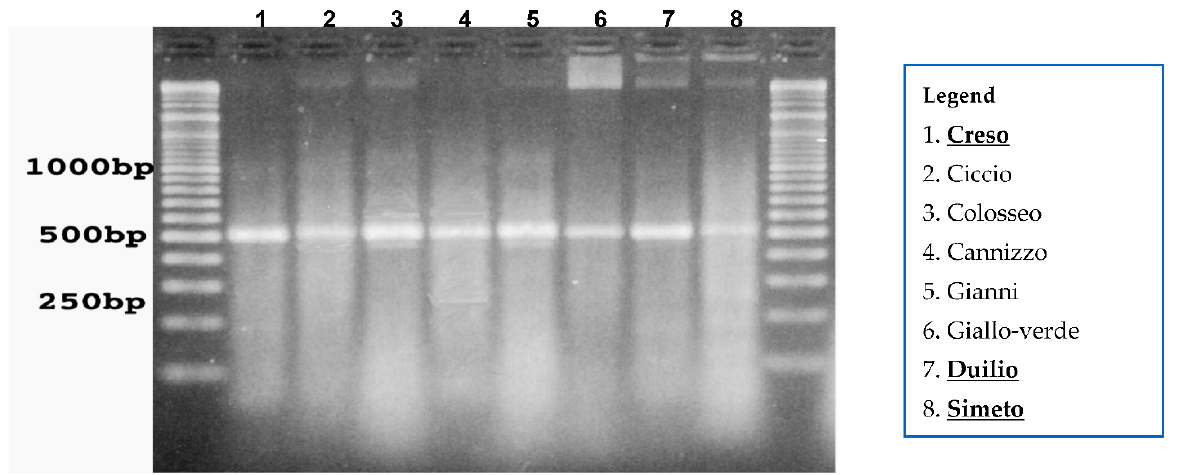
Figure 9. The expression pattern of RT-PCR with primer drebfor1 e drebrev1 of some durum wheat cultivars, including Creso (1), Duilio (7) and Simeto (8) analyzed at the 4th day without water.